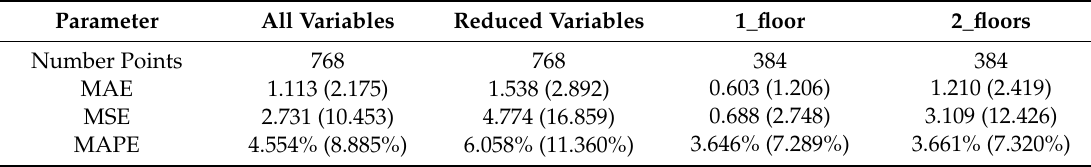
Table 8. Quality parameters for the mixed and restricted models of the cooling load problem.